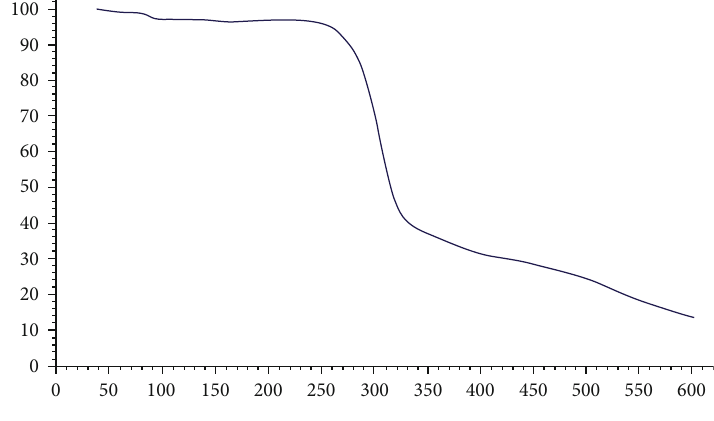
Figure 1: The TGA curve of Cu(H